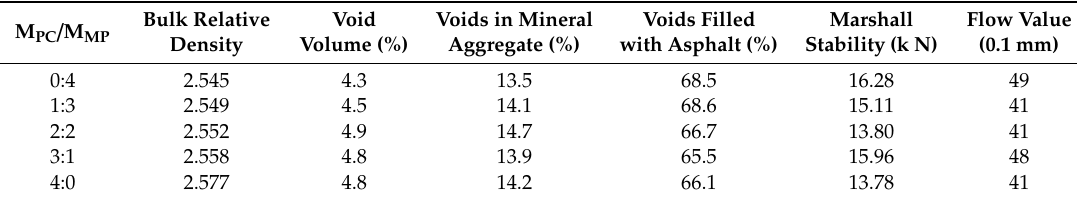
Table 7. Volumetric parameter and Marshall test results.